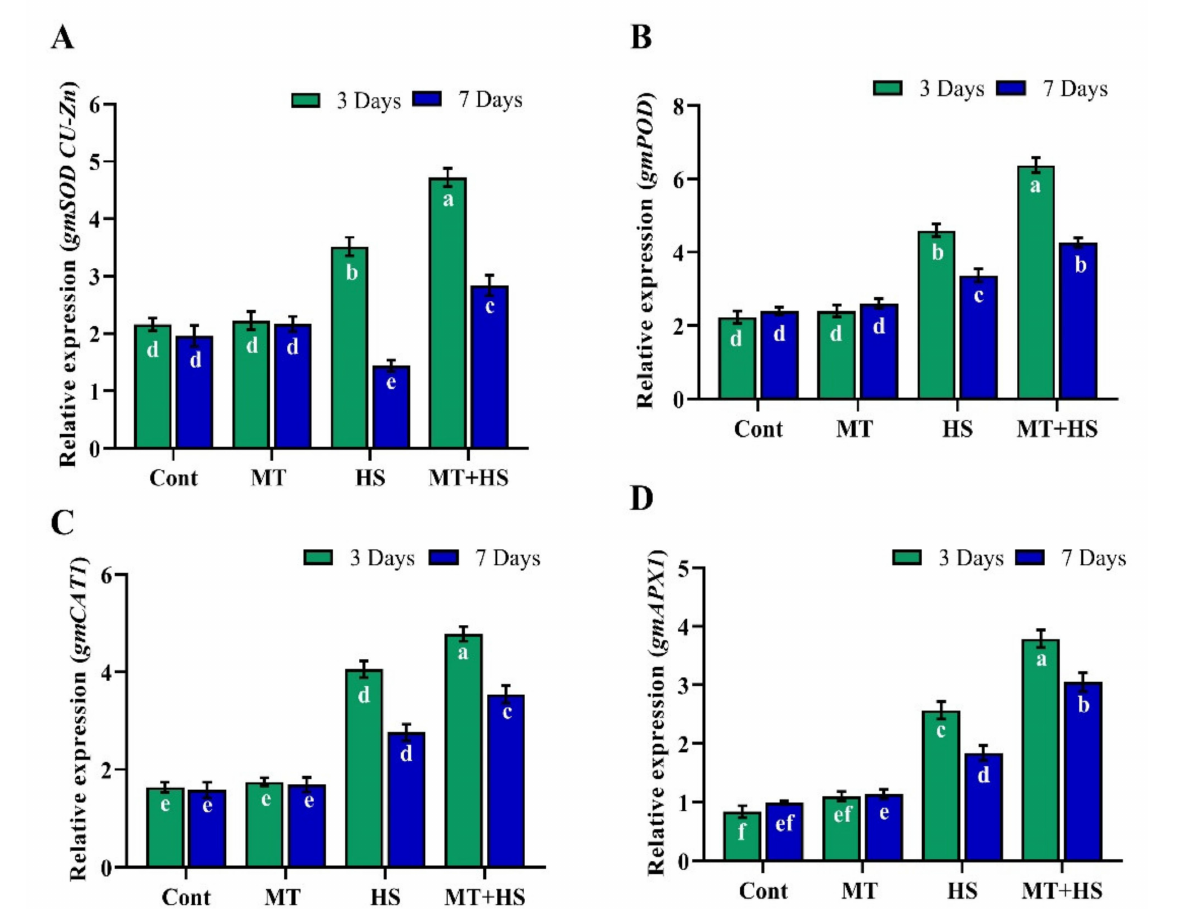
Figure 3. Effects of melatonin application with or without high temperature (42 ◦ C) on the relative expression of ( A ) gmSOD (CU-Zn), ( B ) gmPOD, ( C ) gmCAT, and ( D ) gmAPX in soybean seedling after 3 and 7 days. Each data point is the mean of three replicates. Error bars represent the standard error of the mean. Bars with different letters are significantly different from each other by Duncan’s multiple range test at p ≤